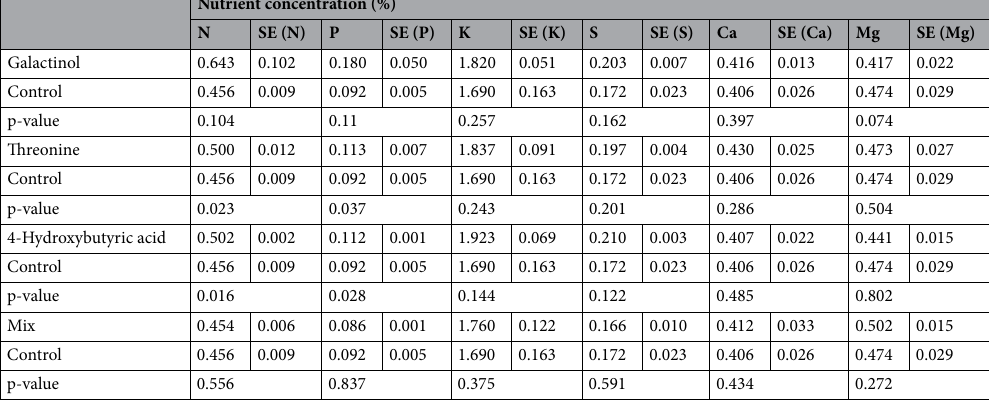
Table 2. Macro and micronutrients concentration in corn roots amended with root exudates. T-test show comparison of nutrient levels between treatments amended with compounds and an untreated control. Table shows mean, and standard error (se) calculated from 10 replicates per